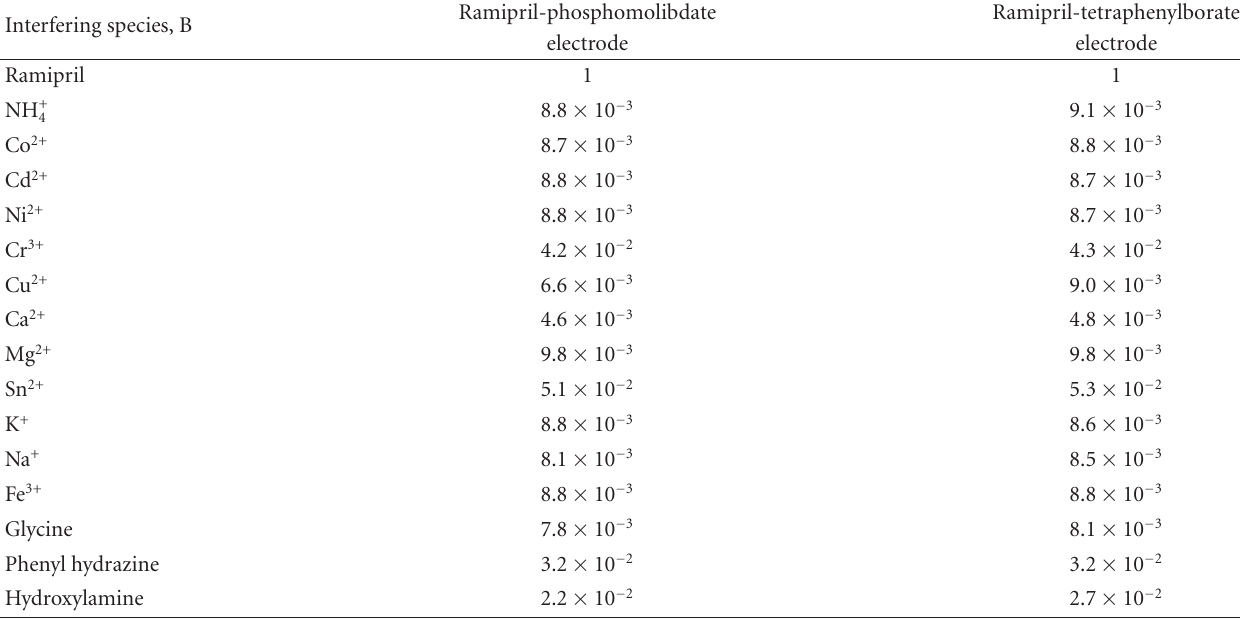
Table 2: Potentiometric selectivity coe ffi cients ( K pot electrodes.